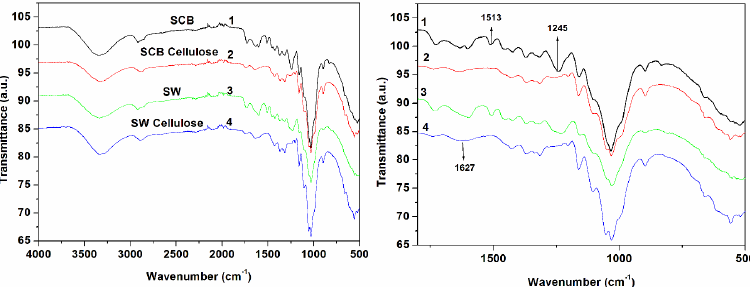
Figure 1. FTIR spectra of untreated SCB, SCB cellulose, untreated SW, and SW cellulose.